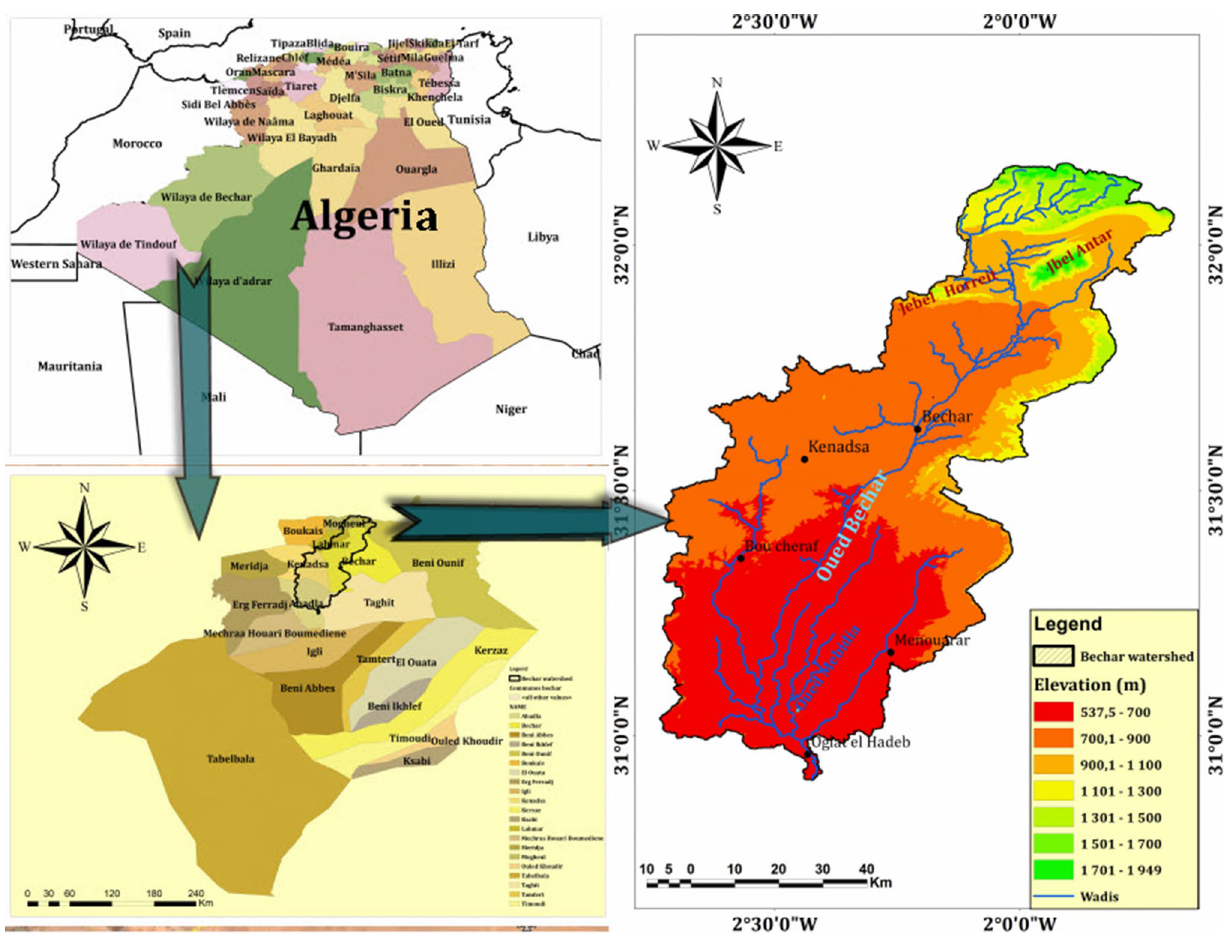
Fig. 1 Geographical location of the Wadi Bechar watershed (Bekhira et al.